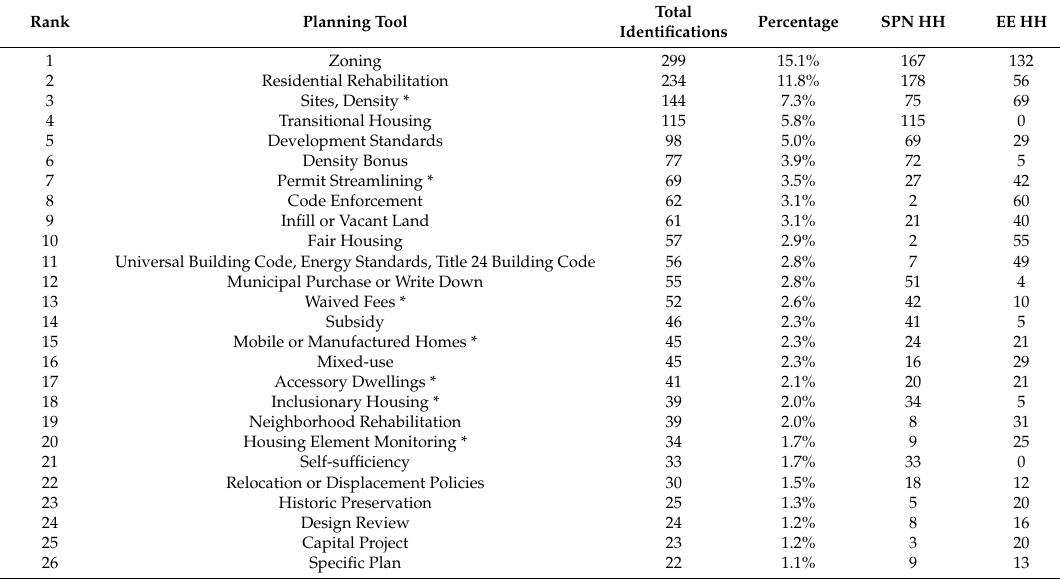
Table A3. Planning tools ranked by total